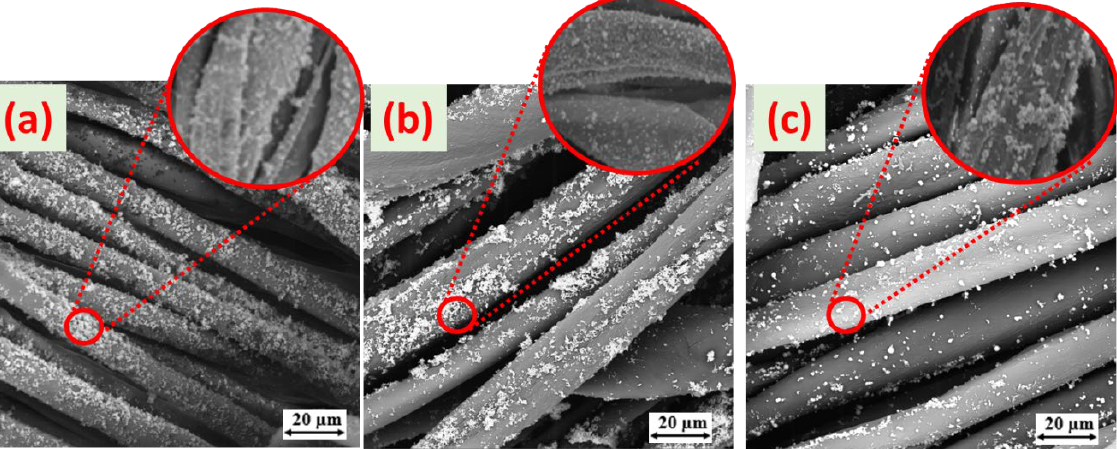
Figure 7. Surface morphologies of cotton fabrics coated with cuprous oxide particles reduced with ( a ) DS, ( b ) DA, and ( c ) DG at 100× magnification and their close view at a magnification of 5k×.